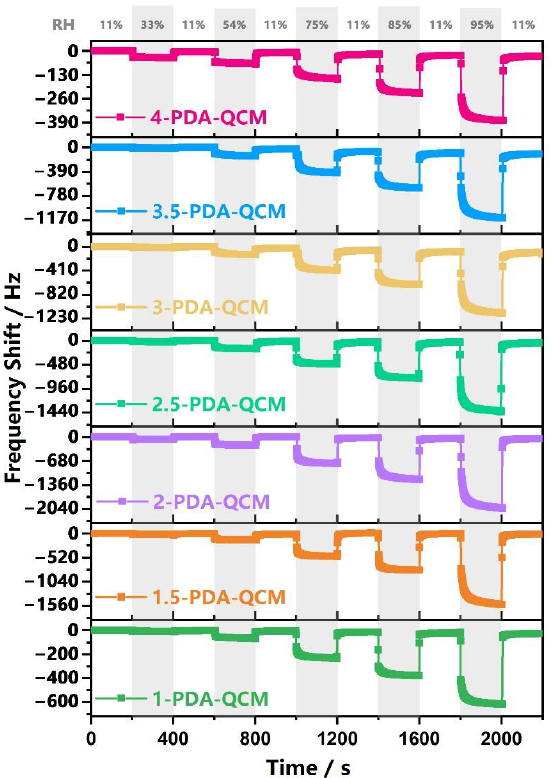
Figure 5. The response-recover curves of 1-PDA-QCM, 1.5-PDA-QCM, 2-PDA-QCM, 2.5-PDA- QCM, 3-PDA-QCM, 3.5-PDA-QCM, 4-PDA-QCM at the relative humidity between 11% and 95%. 3-PDA-QCM, 3.5-PDA-QCM, 4-PDA-QCM at the relative humidity between 11% and